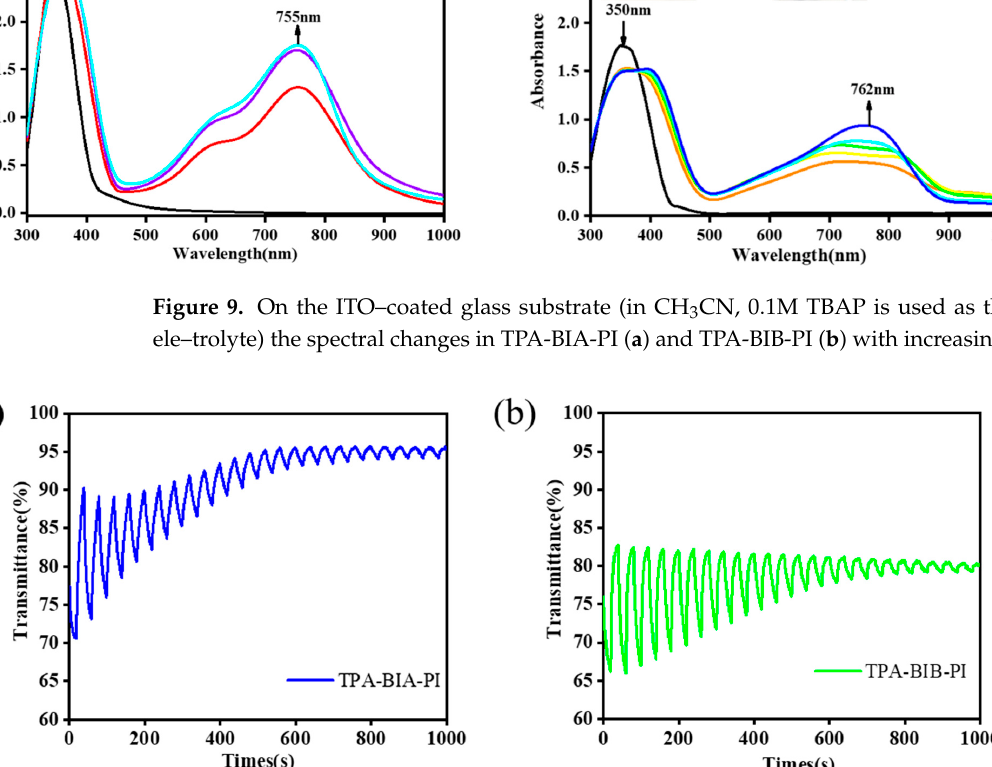
Figure 10. Optical switching between -0.4 and 1.6 V of the polyimide TPA-BIA-PI ( a ) film and -0.4 and 1.8 V of the polyimide TPA-BIB-PI ( b ) on the ITO-coated glass substrate in 0.1M TBAP/CH 3 CN with a cycle time of 20 s.